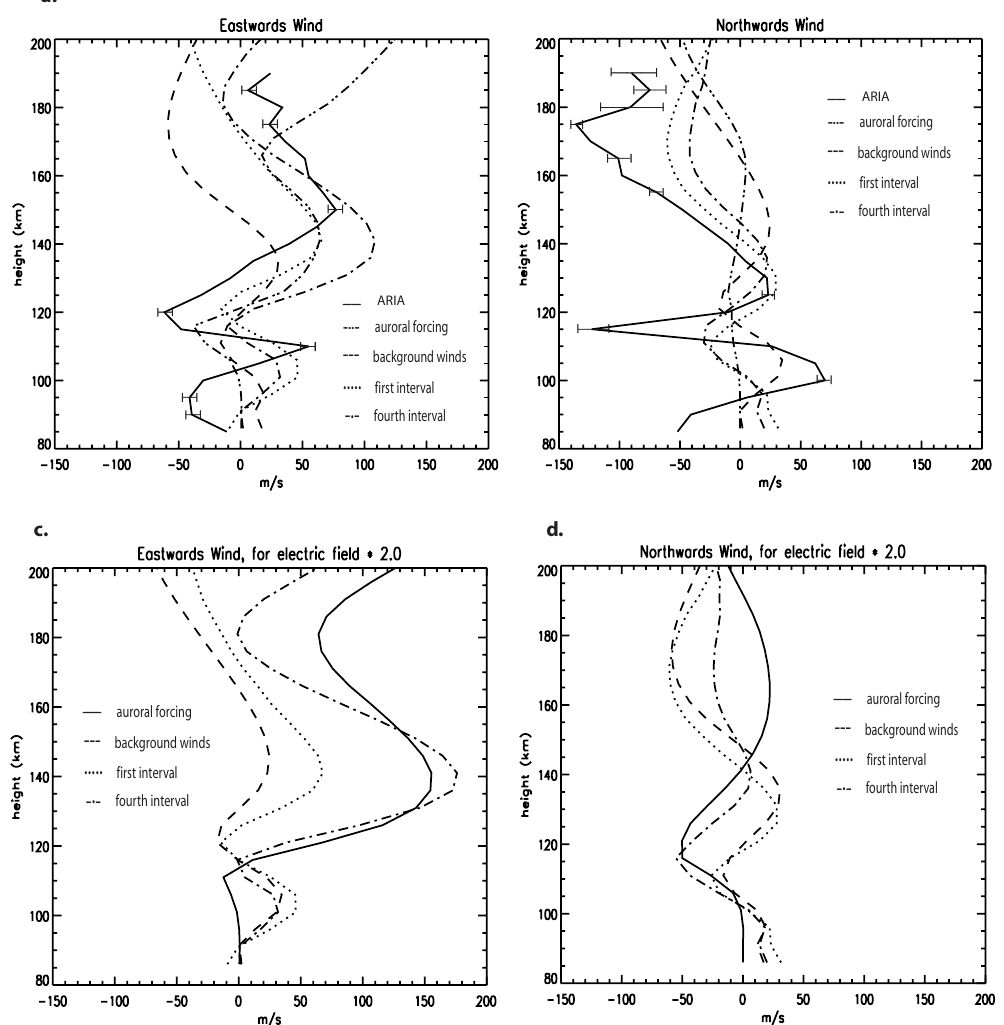
Fig. 8. (a) , (b) Response of the neutral winds to different combinations of auroral forcing and background winds and tides, with ARIA I observations included for comparison. (c) , (d) Response of the neutral winds to different combinations of auroral forcing and background winds and tides, with the electric field multiplied by